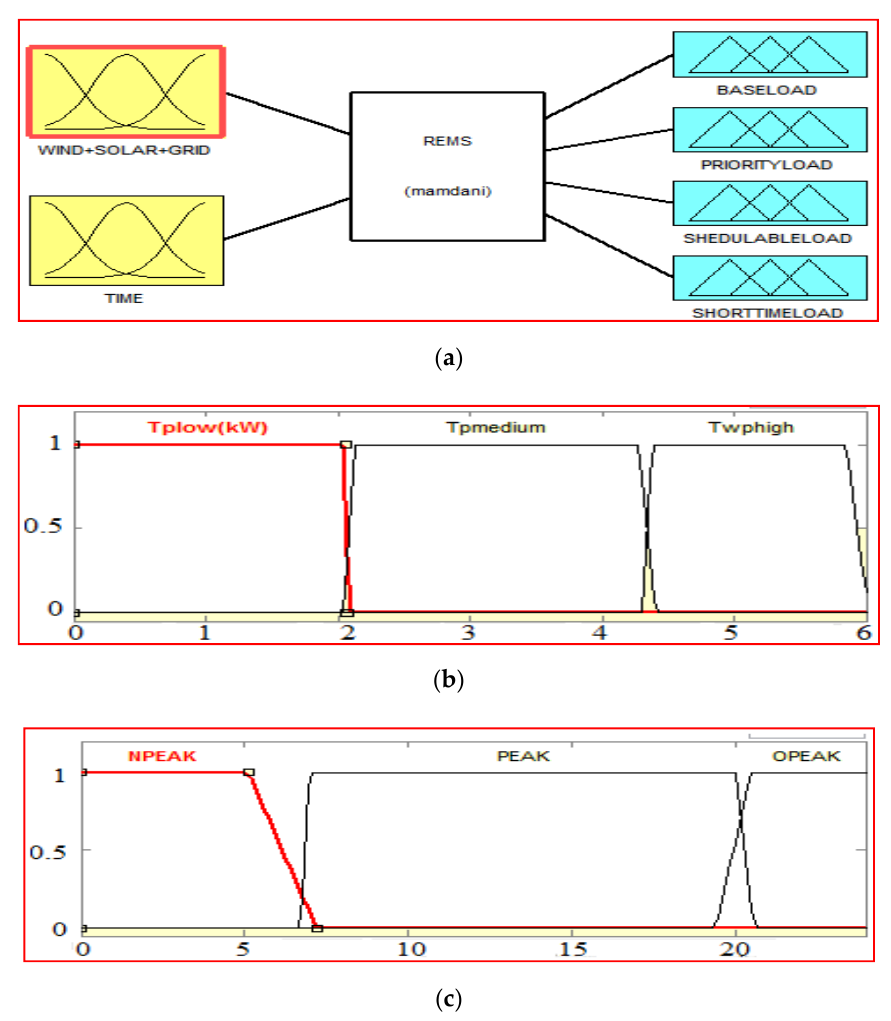
Figure 11. Renewable energy management (REM) system ( a ) input and output fuzzy variables ( b ) Input variable “wind + solar + grid” versus power in kW ( c ) Input variable versus time in hours.